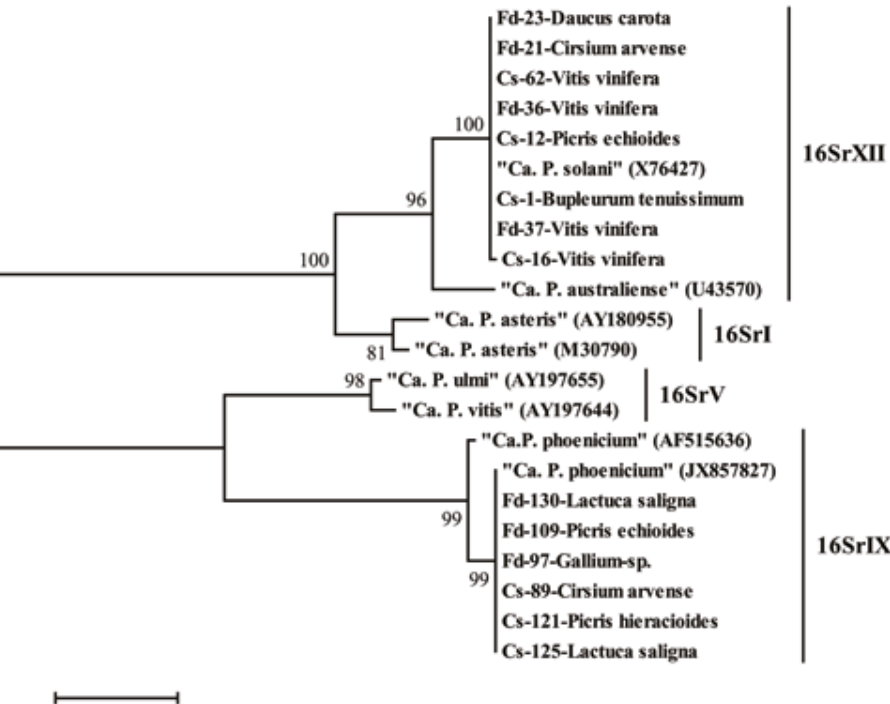
Figure 3. Maximum likelihood tree showing the phylogenetic relatedness between phytoplasmas found in vineyard plots Cs and Fd, and representative members of the ribosomal groups 16SrI, V, IX and “ Ca . P. solani” (16SrXII-A). GenBank ac- cession numbers are shown in parentheses. The tree was built using the sequences of a fragment of the 16S rRNA gene (1126 positions in the final dataset). Numbers above or below branches are bootstrap values based on 500 pseudoreplicates under the Tamura 3-parameter model of evolution with gamma rate of variation across sites. Nucleotide sequences deter- mined in this study are indicated by Cs or Fd according to the vineyard plot of